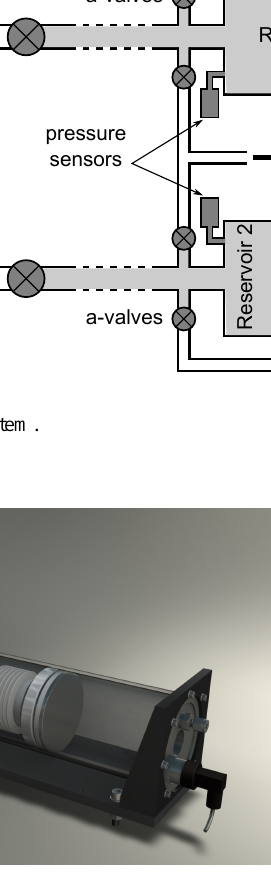
Fig. 3. 3-D drawing of one of the two “mechanical syringes” of the MEDEE system. The cylindrical reservoir is made transparent on the illustration in order to show the moving piston. The gray rectangular box on the left houses the jack screw, which is moved by the engine inside the black compartment above